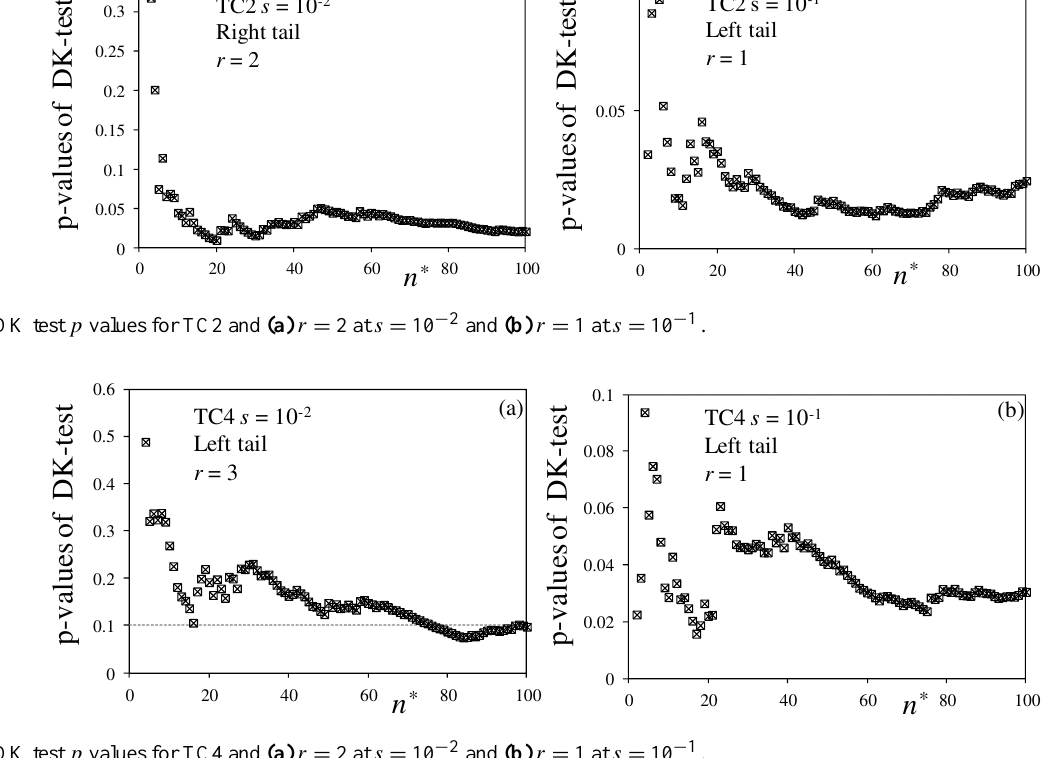
be true for synthetic samples of iid α -stable random